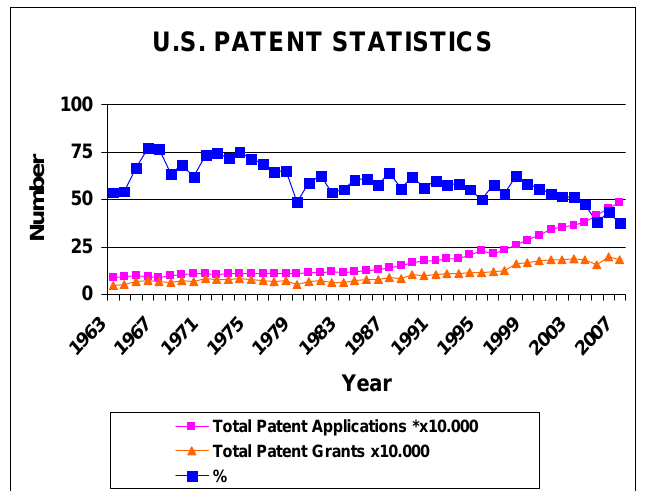
Figure 4. U.S. Patent Statistics